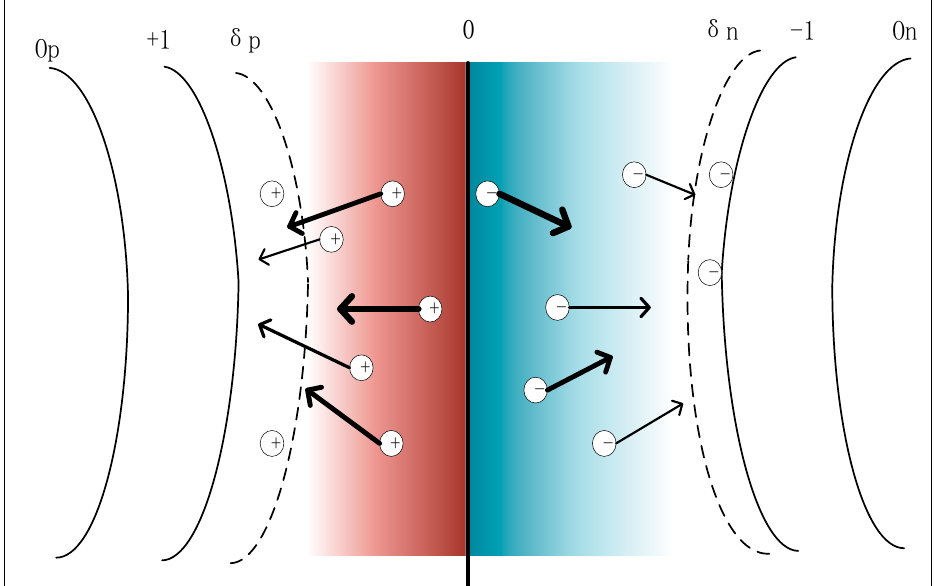
Figure 2. The dotted line represents the boundary of δ p and δ n , and the colored areas inside represent the areas that need to be optimized. The darker the color, the greater the optimization degree, and the lighter the color, the smaller the optimization degree. The circle with “+” is a positive sample, which is optimized toward the optimal O p direction, while the circle with “-” is a negative sample, which is optimized toward the optimal O n direction. At the same time, the direction of the arrow denotes the optimization direction, and the thickness indicates the optimization degree.